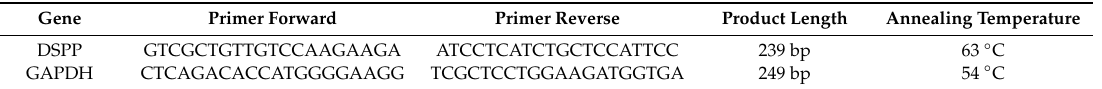
Table 1. Primers used in